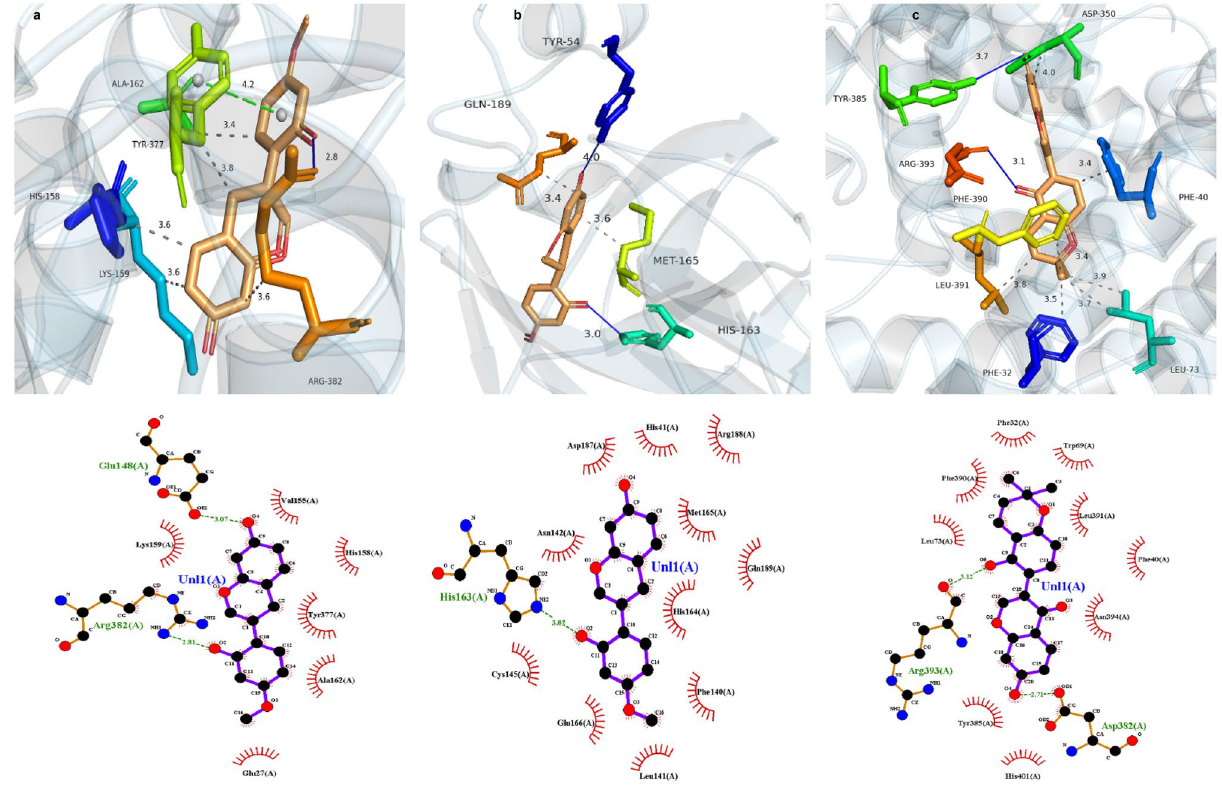
Figure 4. Molecular docking analysis of the selected compounds and targets with the largest binding values. ( a ) The docking mode of glabrone and S-protein. ( b ) The docking mode of glabrone and Mpro. ( c ) The docking mode of vestitol and